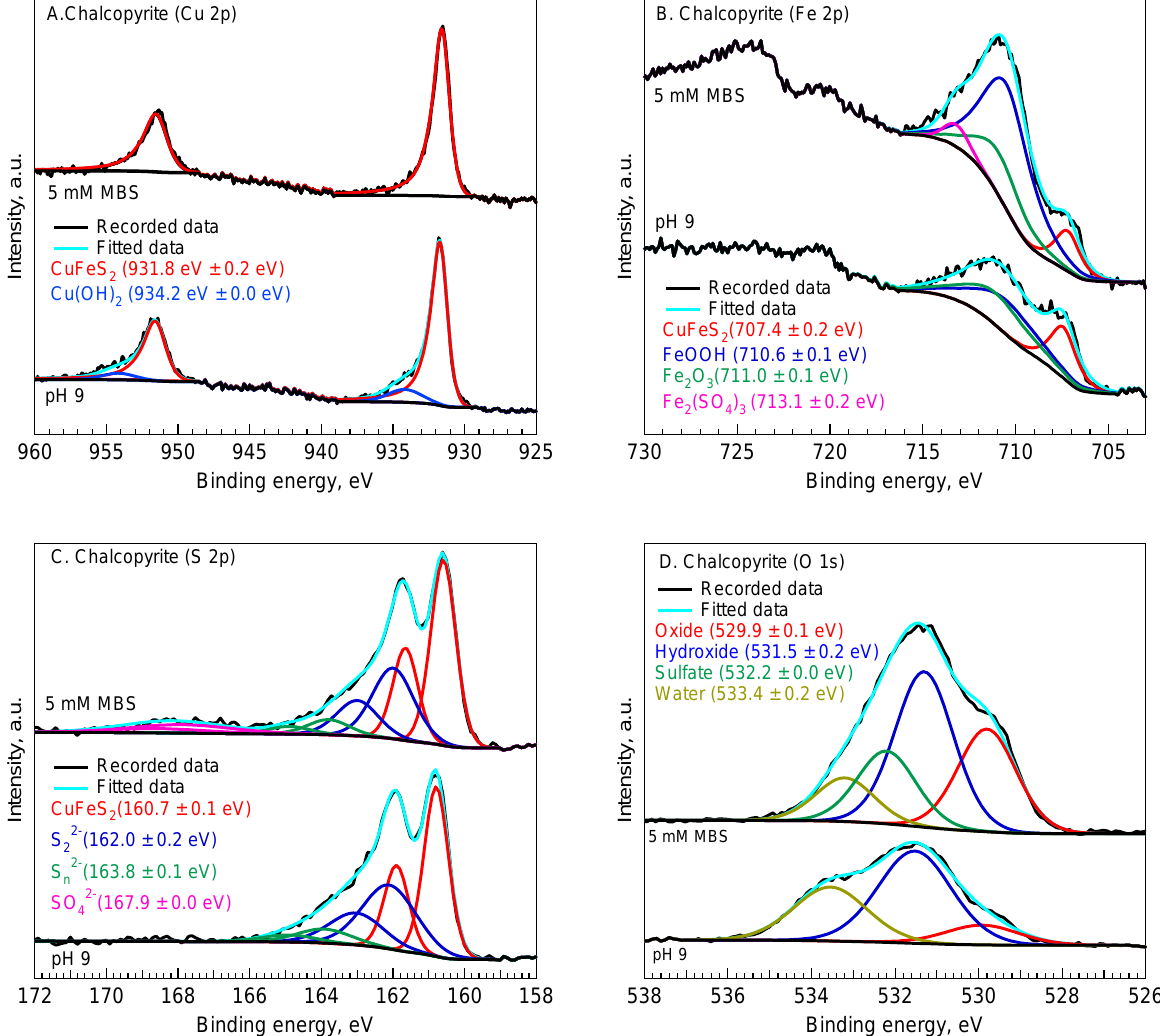
Figure 3. Cu 2p ( A ), Fe 2p ( B ), S 2p ( C ), O 1s ( D ) spectra of chalcopyrite without and with 5 mM MBS treatment at pH 9.